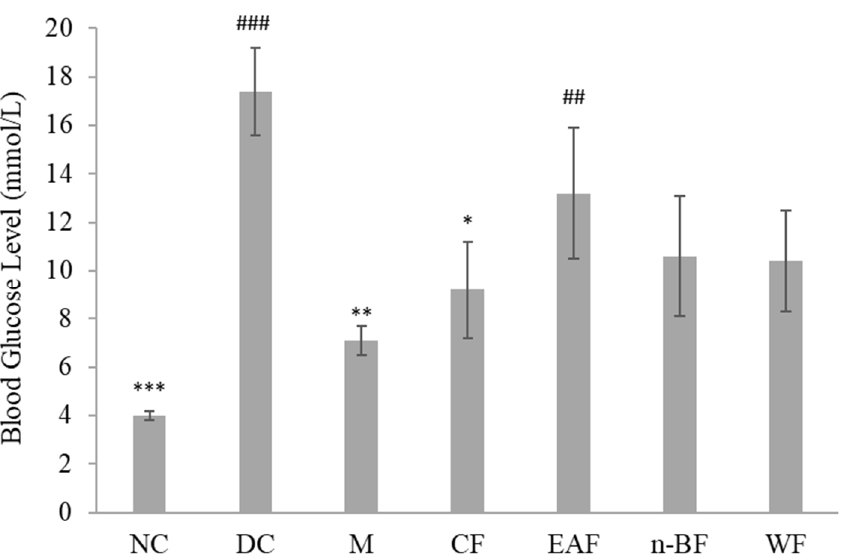
Figure 1. Effects of the fractions of S. polyanthum ’s methanol extract on the blood glucose levels of streptozotocin-induced diabetic rats after being treated orally twice daily for six days. NC, normal control (normal saline, 10 mL/kg); DC, diabetic control (normal saline, 10 mL/kg); M, metformin (500 mg/kg); CF, chloroform fraction (500 mg/kg); EAF, ethyl acetate fraction; n -BF, n -butanol fraction (500 mg/kg); WF, water fraction (500 mg/kg). The values are expressed as mean ± SEM ( n = 6). # indicates significant differences as compared to the NC ( ### p < 0.001 and ## p < 0.01). * indicates significant differences compared to the DC (*** p < 0.001, ** p < 0.01, and * p < 0.05) as analyzed using Dunnett’s as post hoc